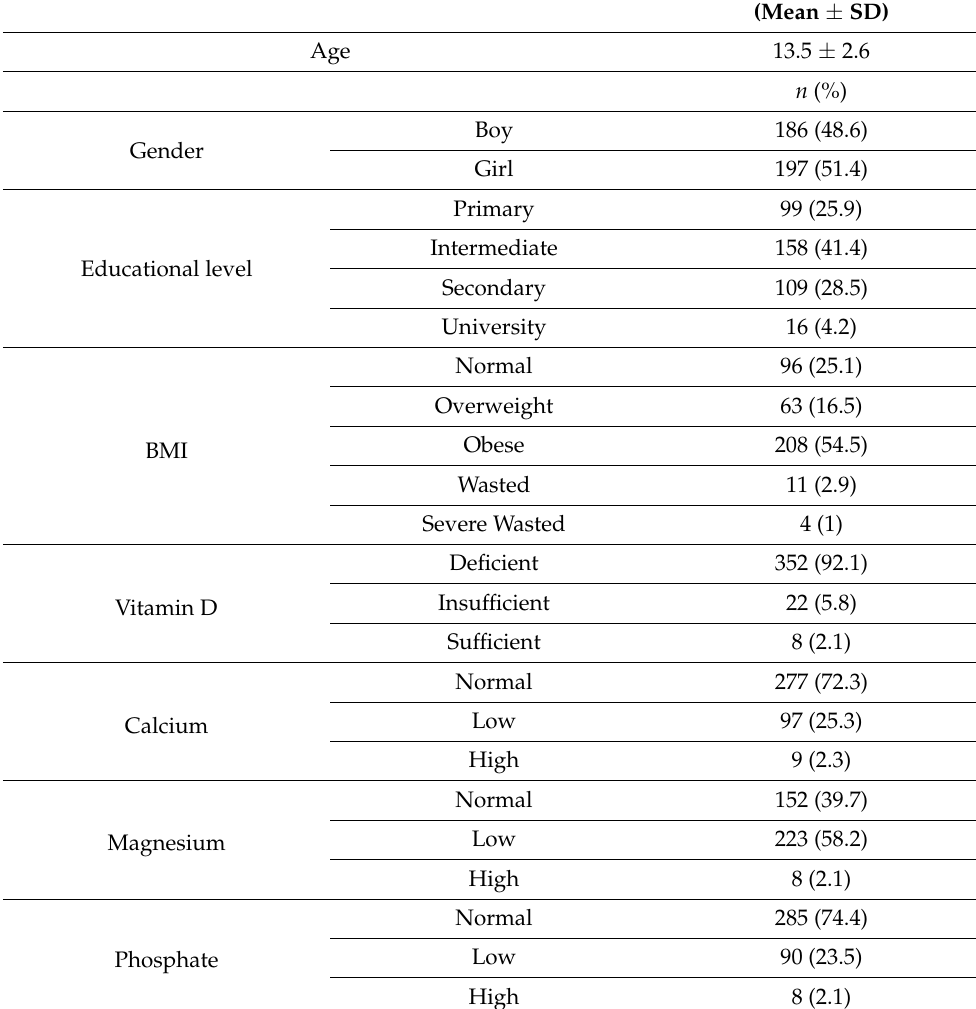
Table 1. Participant characteristics ( n =